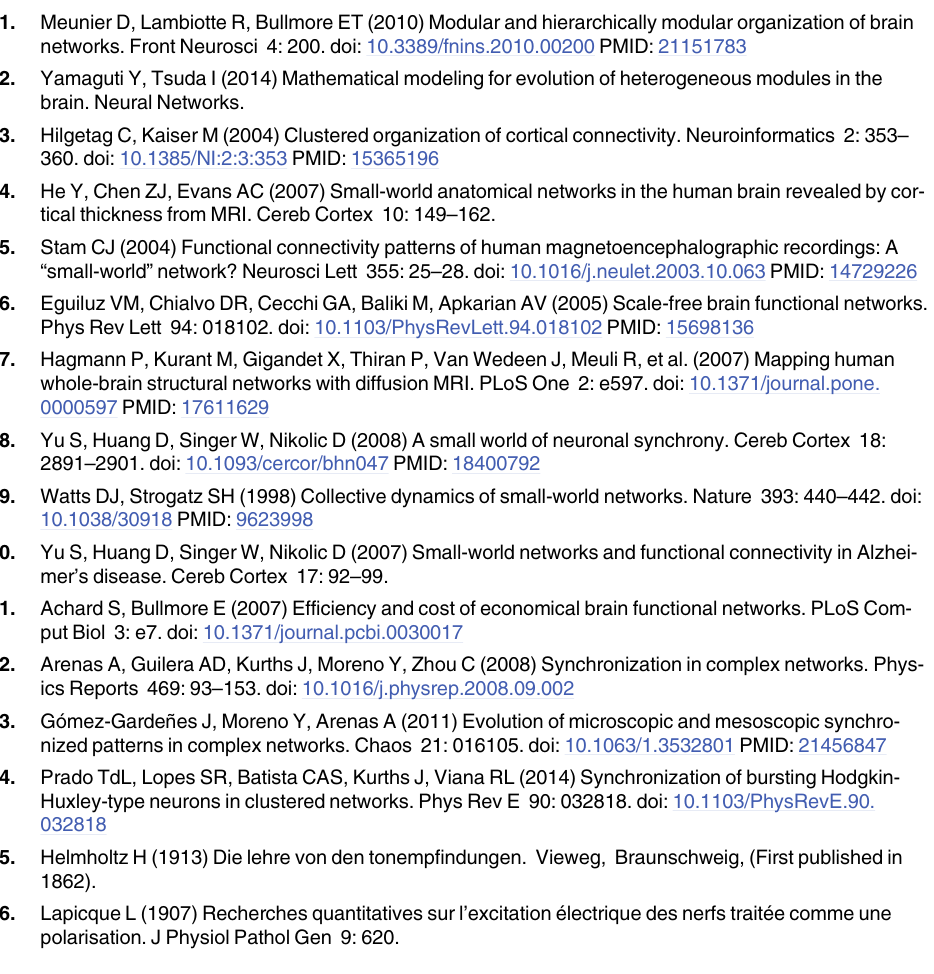
S2 Table. Small-worldness measure σ for the C.elegans and human brain networks and for their